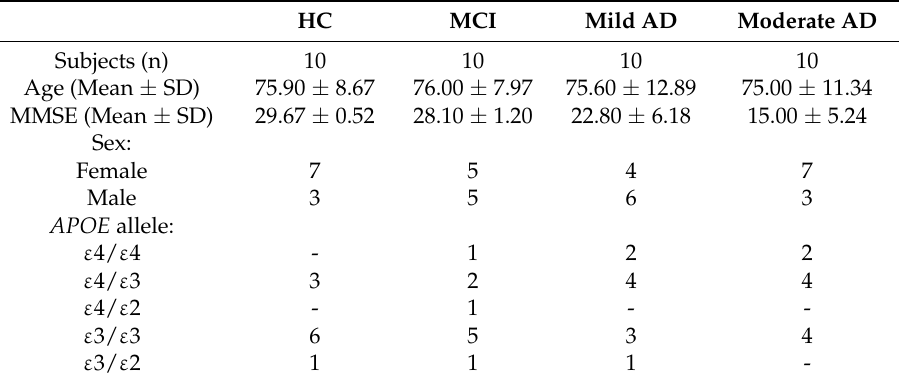
Table 1. Demographics and clinical characteristics of plasma